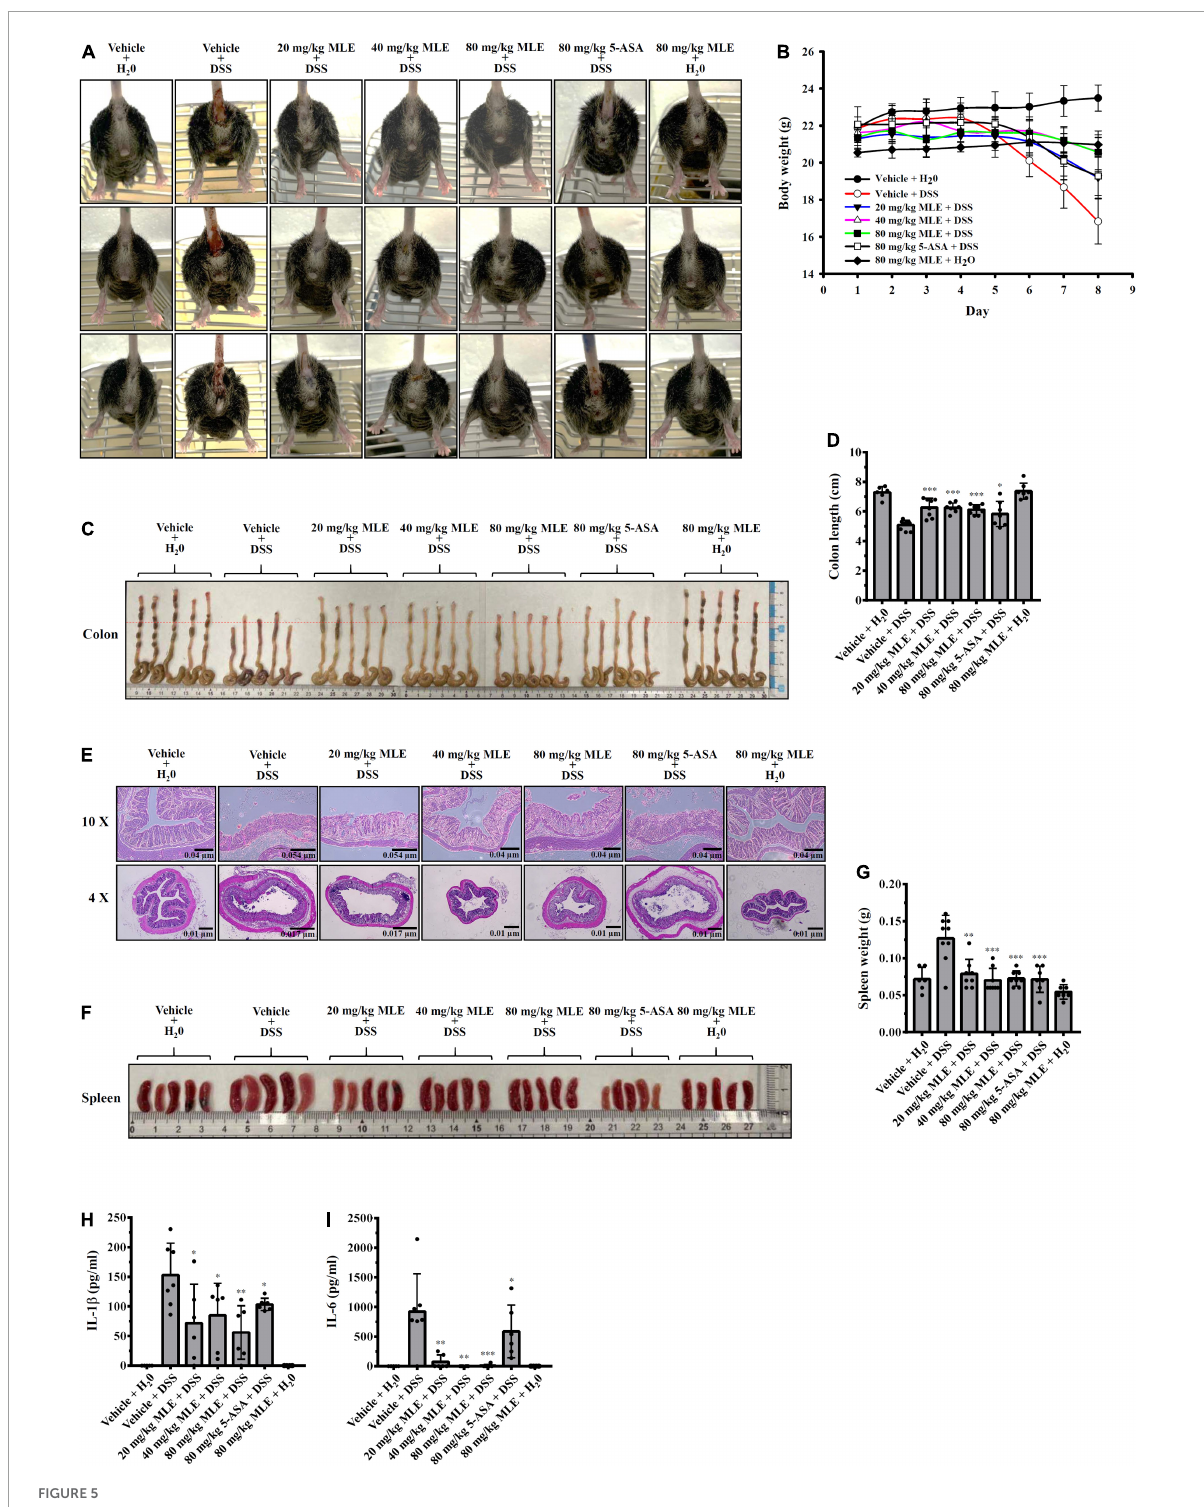
FIGURE5 MLE ameliorates DSS-induced colitis in a mouse model. (A) Images of representative diarrhea and bloody stool from mice. (B) Effect of MLE on body weight loss. (C) Effect of MLE on colonic shortening. (D) The column diagram represents the colon length in (C) . (E) Effect of MLE on colonic damage analyzed by H&E staining. (F) Effect of MLE on splenomegaly. (G) The column diagram represents the spleen weight in (F) . (H) Effect of MLE on the levels of IL-1 β in colon tissue. (I) Effect of MLE on the levels of IL-6 in colon tissue. The data are expressed as the mean ± SD. *, **, and *** indicate a significant difference at the level of p < 0.05, p < 0.01, and p < 0.001, respectively, compared to vehicle + DSS